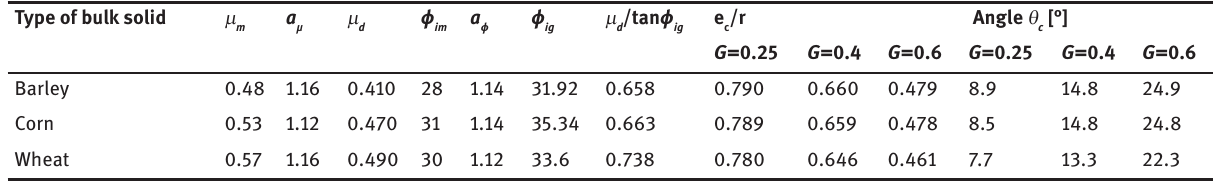
Fig. 2. Non-centric flow channel during emptying and distribution of pressure on the silo wall [12] a)